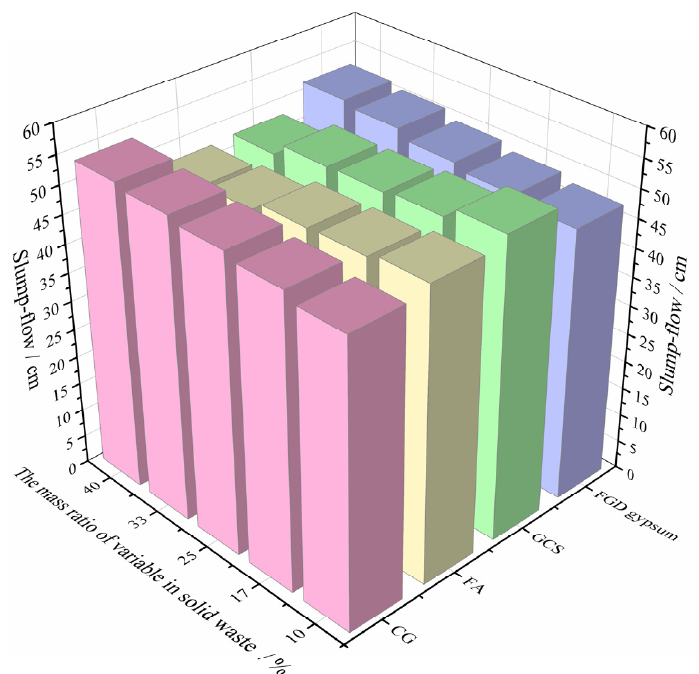
Figure 5. Slump-flow test results.